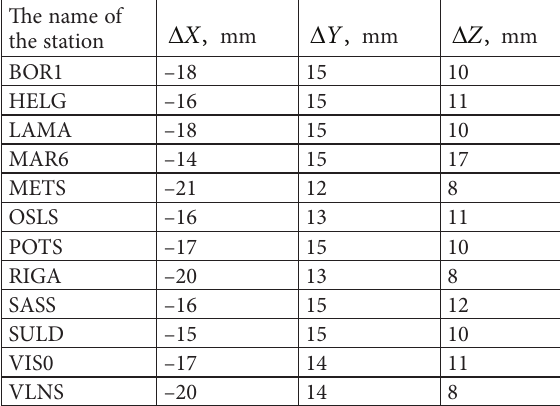
Table 5. The average annual changes in the coordinates of the stations between 2004 and 2011 The name of the